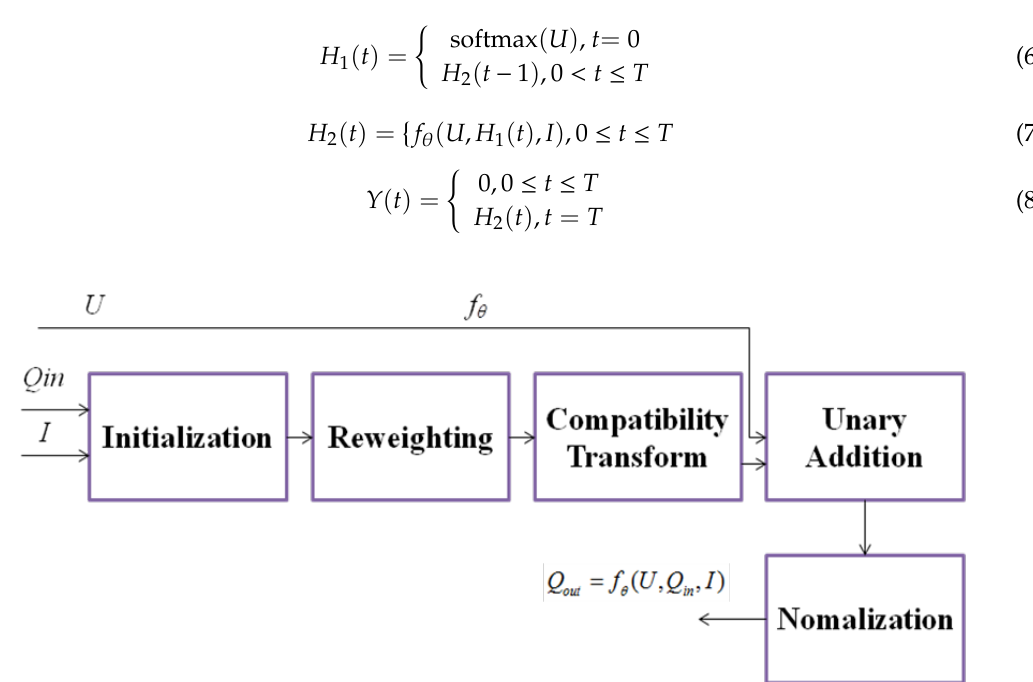
Figure 1. The mean-field approximation reasoning algorithm iterative process.